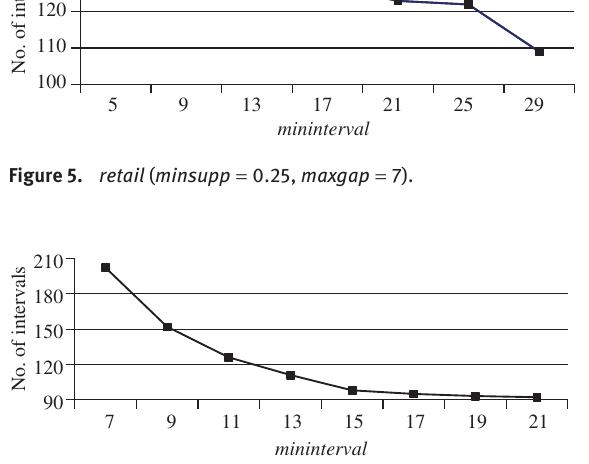
Figure 6. BMS-WebView-1 ( minsupp = 0.06, maxgap = 7).